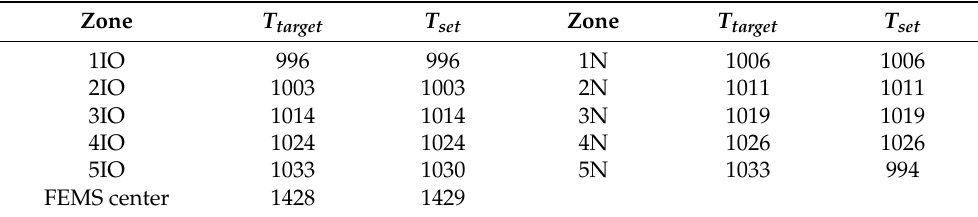
Table 3. Target temperatures for